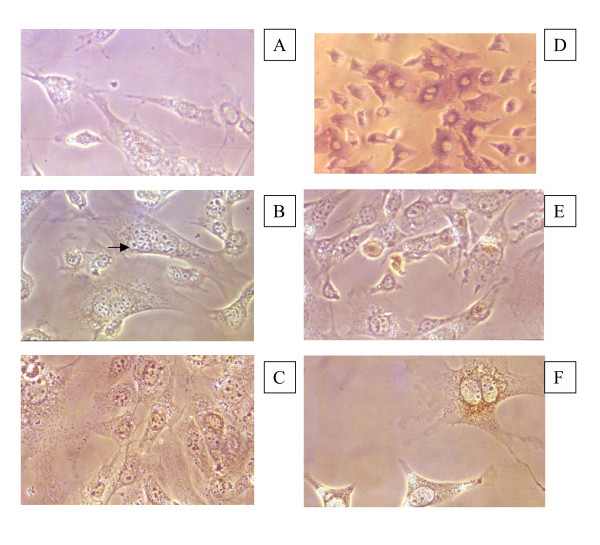
Assay of repair of genomic damage. Examples of non-irradiated cells (A, D) or cells irradiated and allowed to recover for 0 hr (B, E) or 2 hr (C, F) are shown. MM3MG cells are shown in A-C; TLK1B cells are shown in D-F. An arrow points to one of the DAB spots.